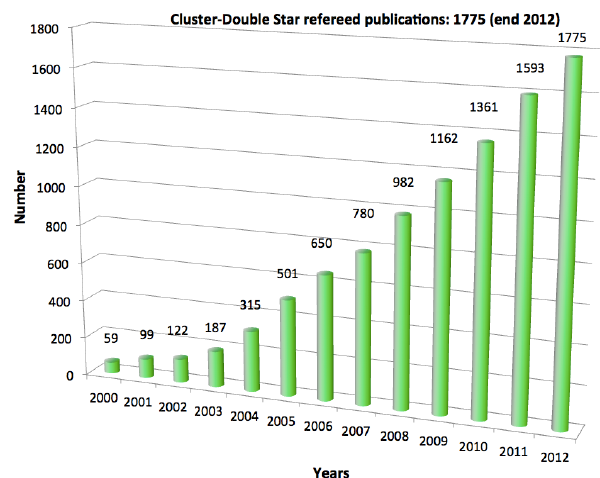
Figure 3. Cluster and Double star referred publications up to end 2012.. 2 Fig. 3. Cluster and Double star referred publications up to end 2012.